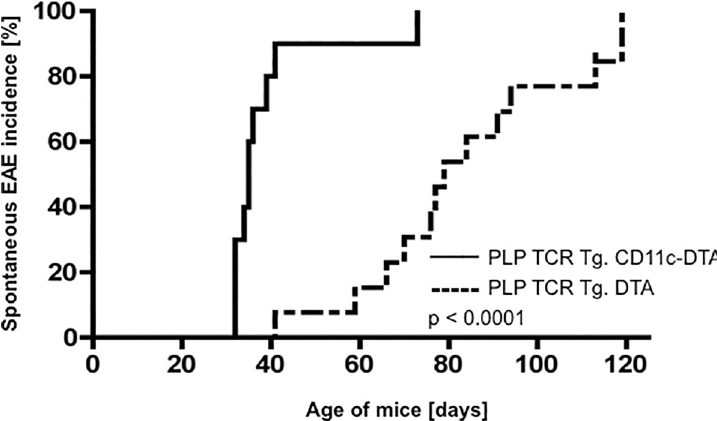
Fig 4. Accelerated onset of spontaneous EAE in PLP TCR Tg. CD11c-DTA SJL mice. PLP TCR Tg. CD11c-DTA SJL mice (n = 9) or PLP TCR Tg. DTA mice (n = 12) were examined up to 120 days after birth for clinical signs of spontaneous EAE. Incidence of spontaneous EAE and statistical significance were determined by Kaplan–Meier analysis and log rank test, respectively. p < 0.0001.